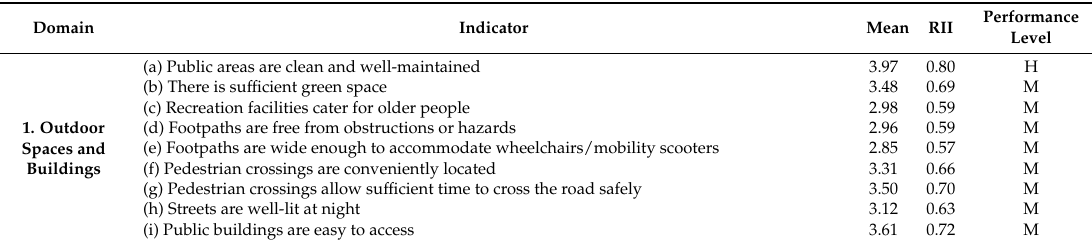
Table 1. Mean value, Relative Importance Index of age-friendly city